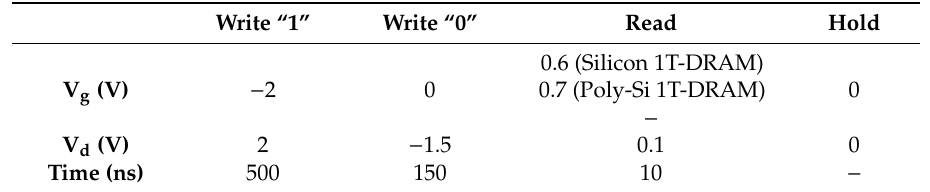
Table 1. Bias conditions for one-transistor dynamic random-access memory (1T-DRAM) operation.